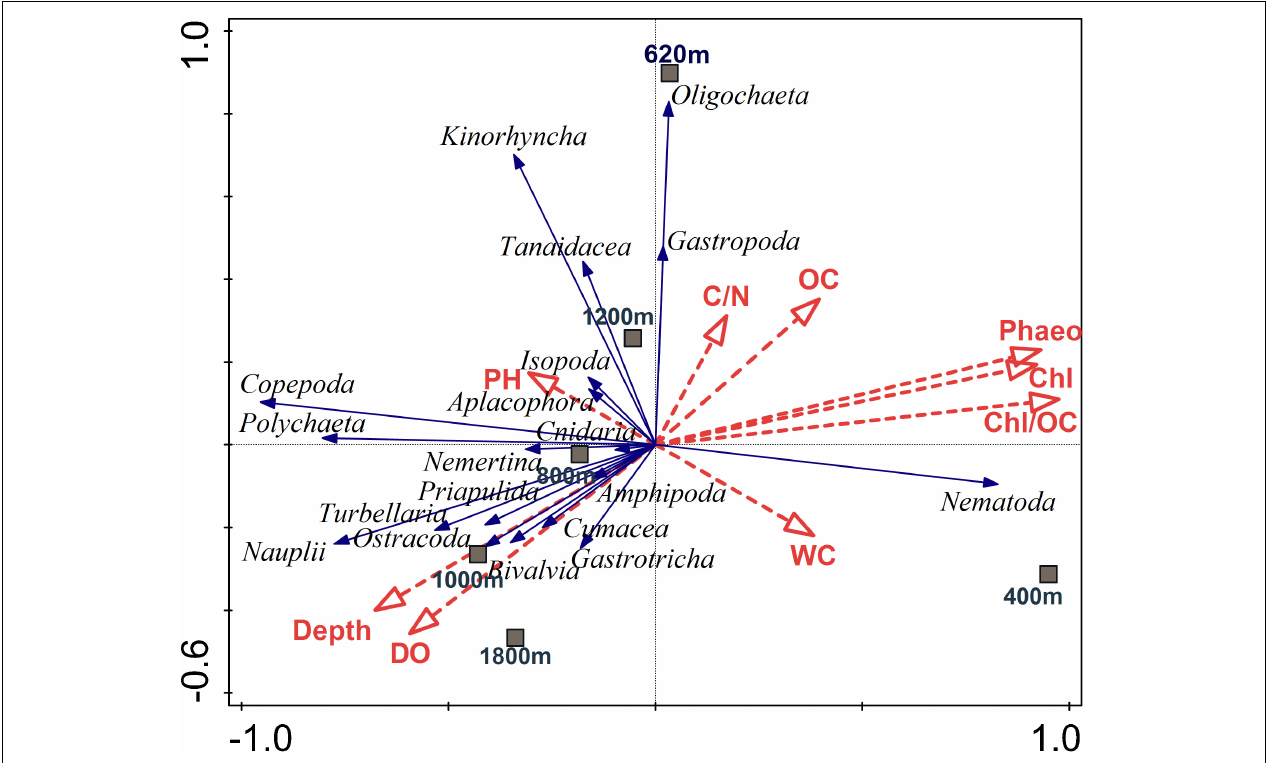
FIGURE 10 | Redundancy analysis (RDA) depicting the meiofauna community on the Costa Rica margin in relation to environmental variables and depth. Dashed red arrows represent the environmental explanatory variables (vectors): OC (total organic carbon), C/N (total organic carbon/total nitrogen ratio), Chl (chlorophyll a ), Phaeo (phaeopigments), Chl/OC (chlorophyll a /total organic carbon ratio), WC (water content), BO (bottom water oxygen), PH (pH bottom-water pH). Solid blue arrows are the meiofaunal taxa (responses). Arrows pointing in the same direction are correlated, and longer arrows indicate increasing values. The first two axes explained 84.8% of the total variance of taxa-environment variance. The relationships were highly significant ( p = 0.002; 999 Monte Carlo